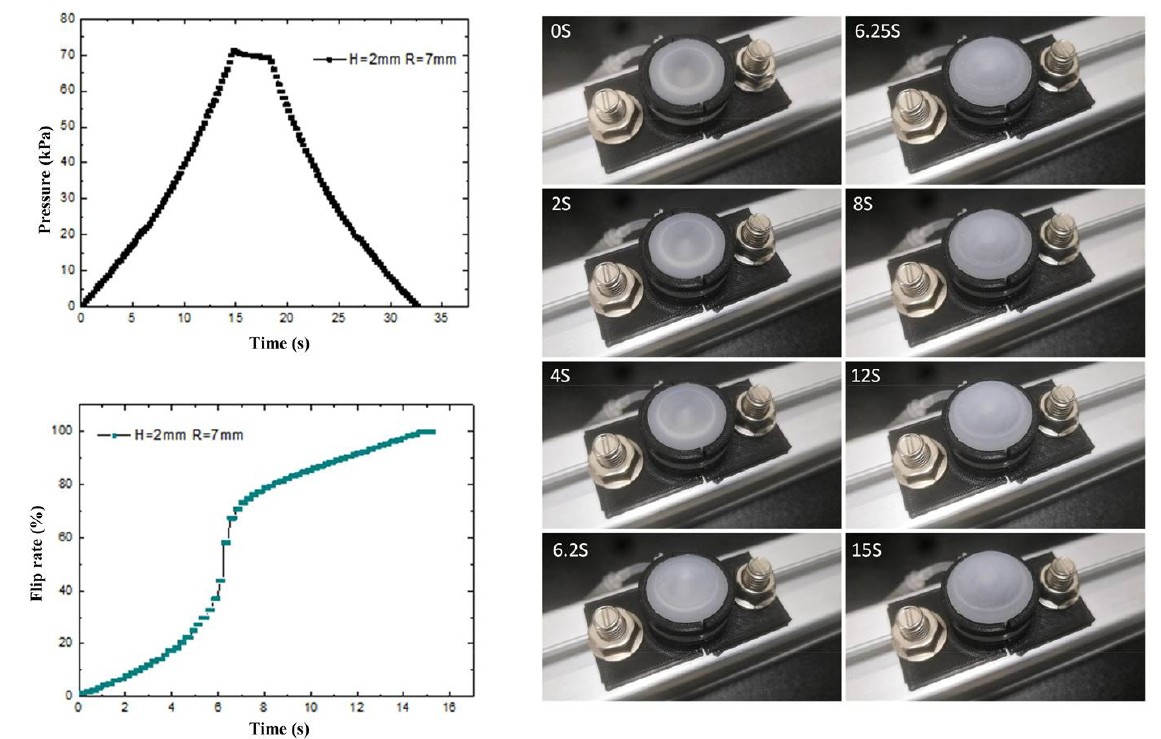
Figure 8. Ball crown membrane overturning process, pressure time variation and loaded overturning rate curve.